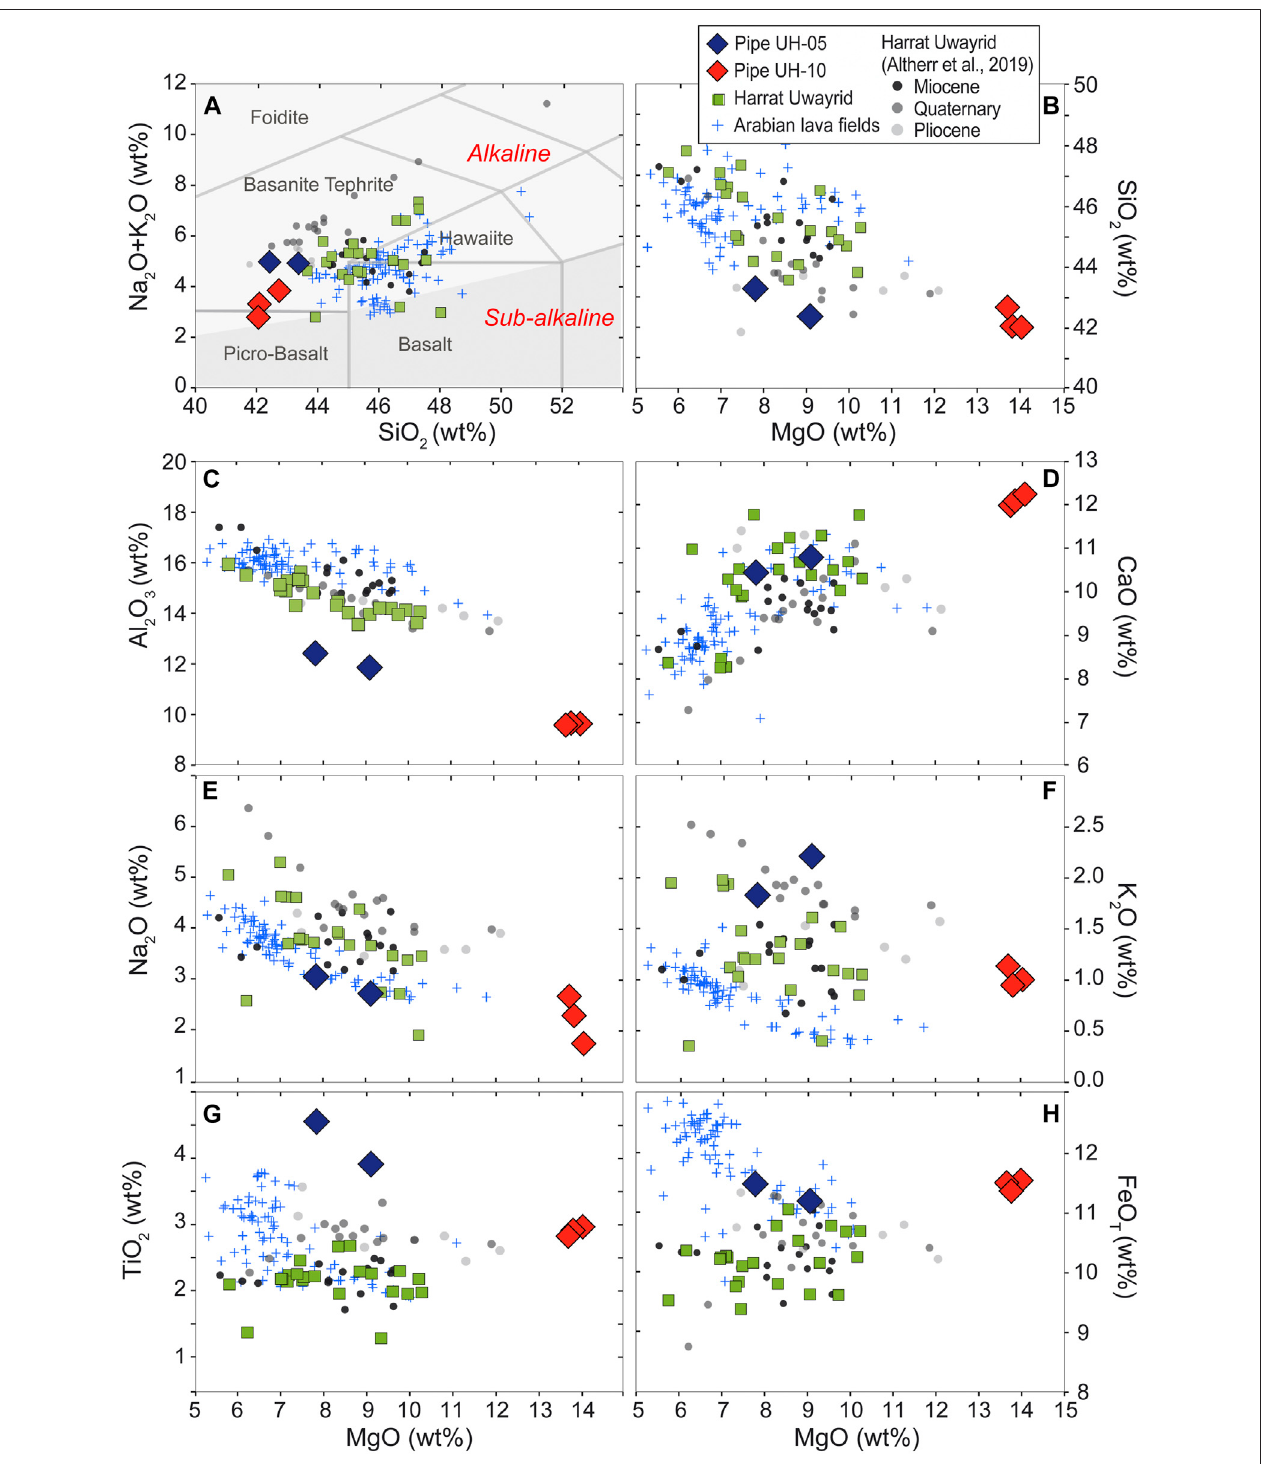
FIGURE 5 | (A) Total alkalis versus SiO 2 diagrams showing the chemical classi fi cation (Le Maitre et al., 2002) of selected samples. Variations in MgO (wt%) versus SiO 2 wt% (B) ,Al 2 O 3 wt% (C) ,CaOwt% (D) ,Na 2 Owt% (E) ,K 2 Owt% (F) ,TiO 2 wt% (G) ,andFe 2 O 3 wt% (H) oflavasfromHarratUwayridandMarthoumvolcanicpipes. Compositions of lavas from Harrat Uwayrid from Altherr et al. (2019) and other Arabian lava fi elds (Moufti et al., 2012; Duncan and AlAmri, 2013; San fi lippo et al., 2019) are also shown.